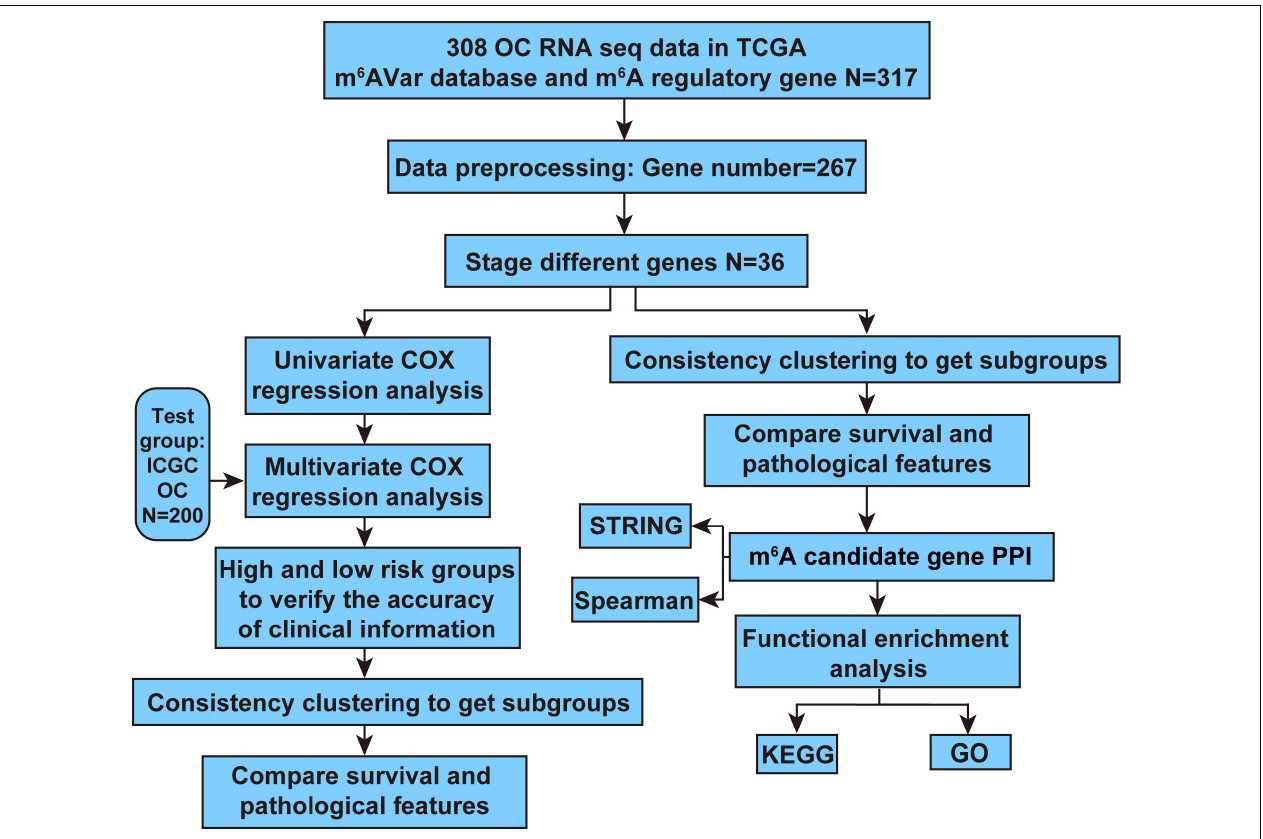
FIGURE 1 | Analysis workflow of this